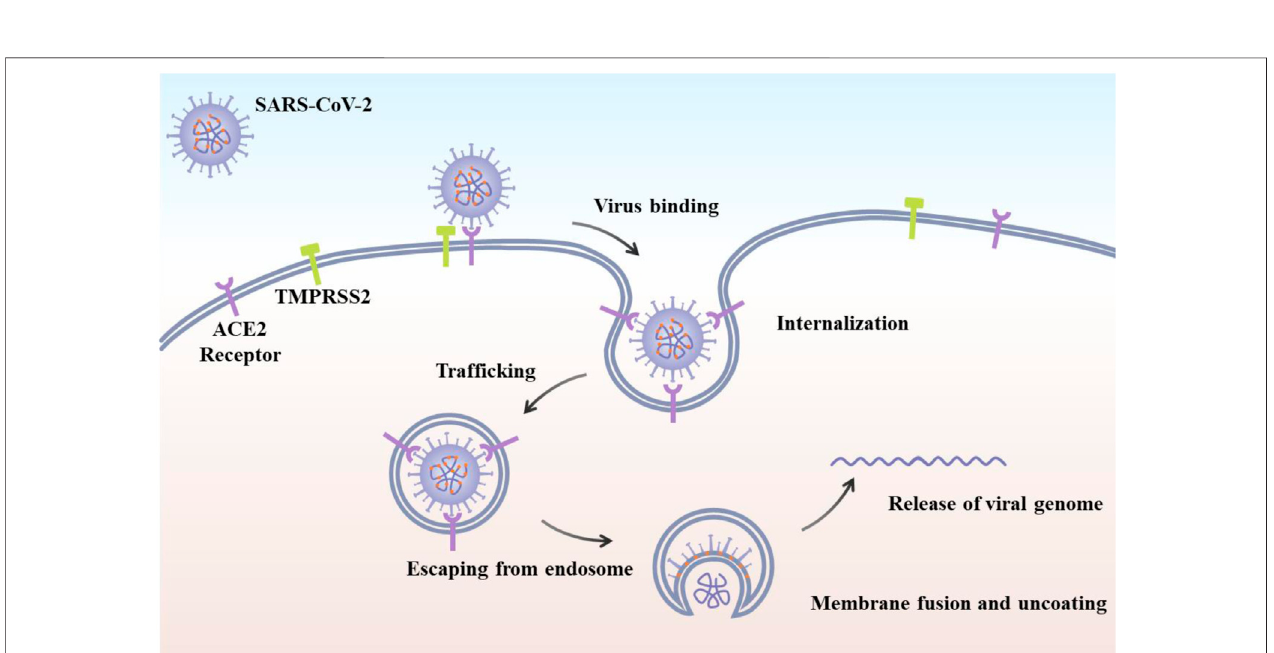
Frontiers in Bioengineering and Biotechnology |